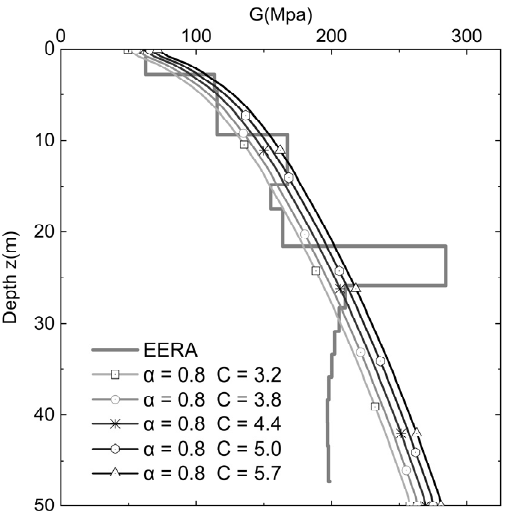
Figure 4. Sensitivity analysis for shear step and boundary condition modulus varying with depth.